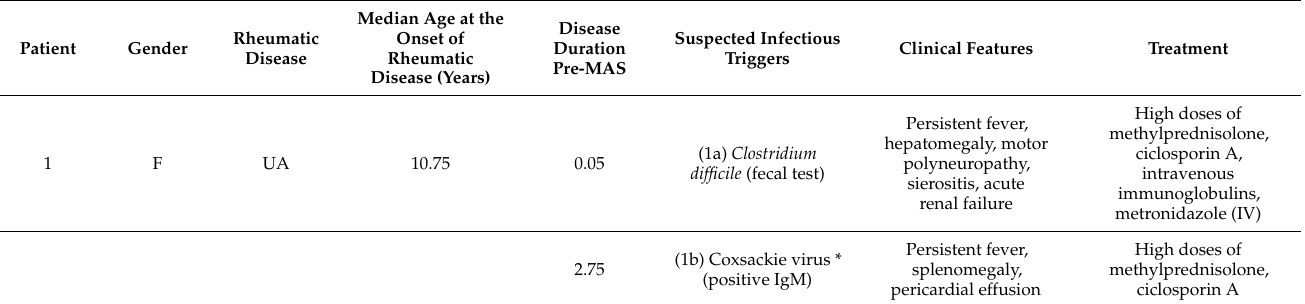
Table 1. Demographic characteristics, clinical features, and treatment of the 12 patients and pathogens